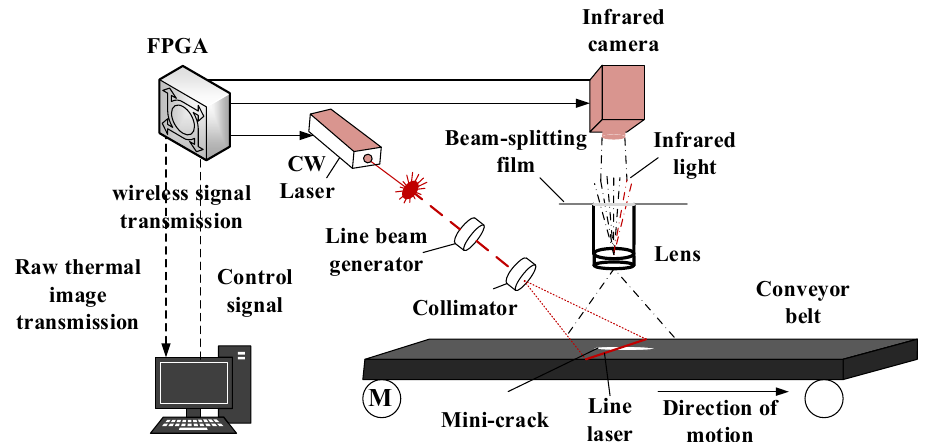
Figure 2. Schematic diagram of longitudinal tear detection system based on laser excited